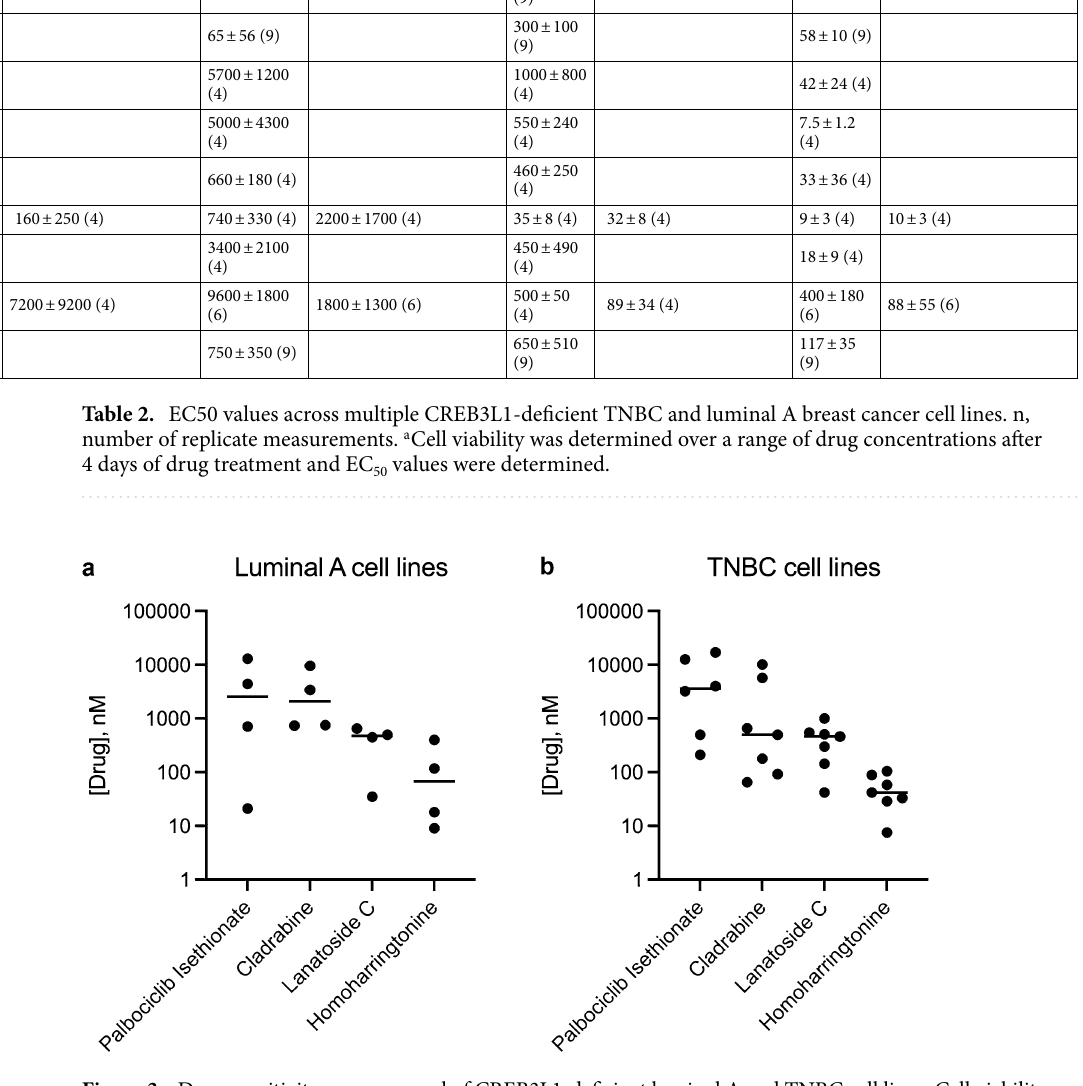
Figure 3. Drug sensitivity across a panel of CREB3L1-deficient luminal A and TNBC cell lines. Cell viability was measured after 4 days of drug treatment over a range of drug concentrations as before. EC 50 values were determined as per Table 2 and plotted here for